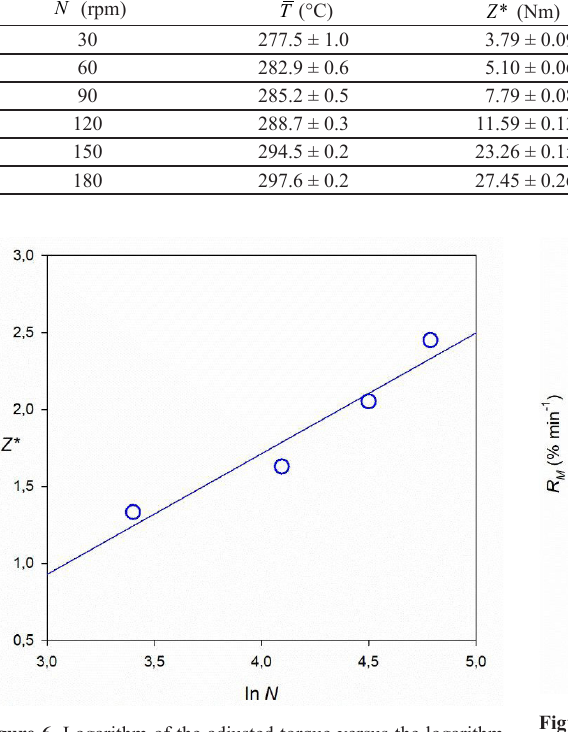
Figure 6. Logarithm of the adjusted torque versus the logarithm of the rotor speed for tests performed at constant chamber wall temperature.